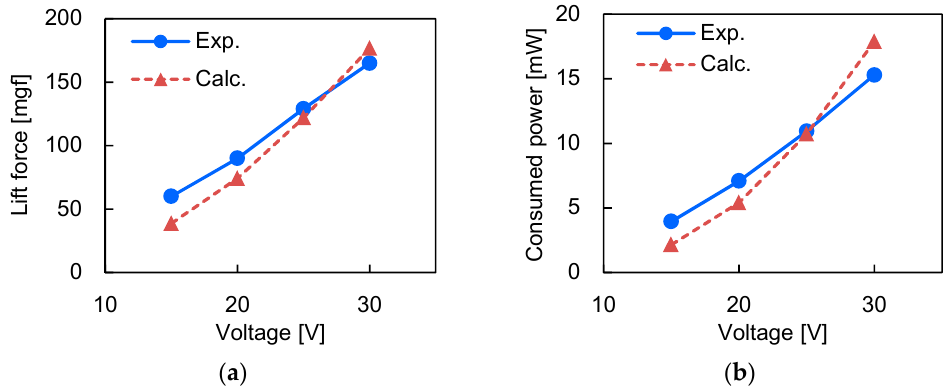
Figure 15. Relationship between applied voltage amplitude and ( a ) lift force and ( b ) consumed power of small-type actuator. The frequencies of the input signal in the experiment and calculation were 210 and 209 Hz, respectively.